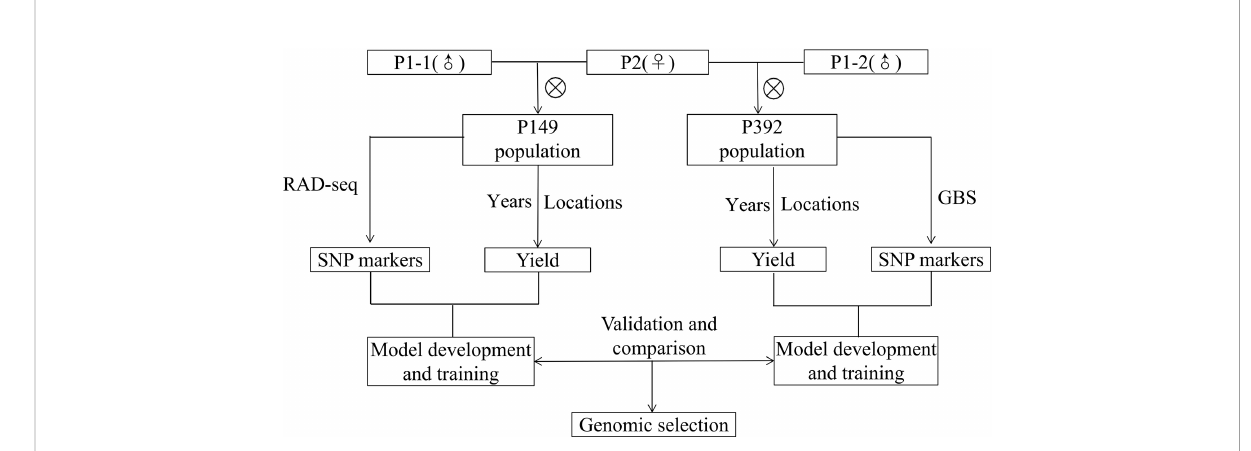
FIGURE 2 Schematic diagram of training, validation and comparison for genomic selection of alfalfa in full-sib